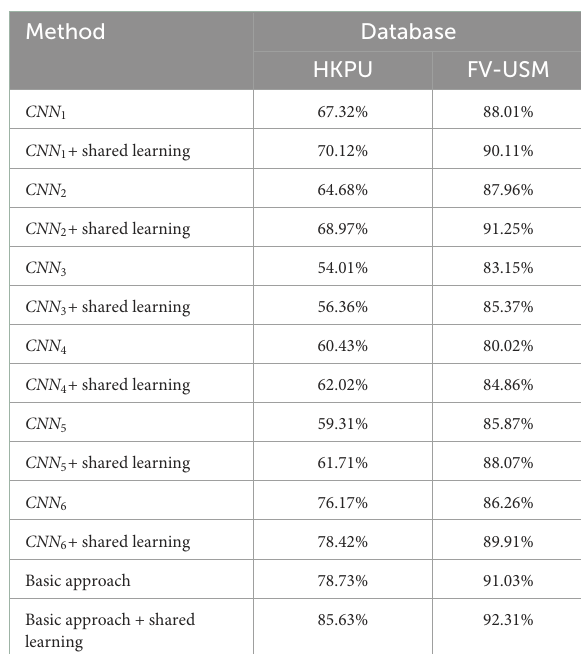
TABLE 6 Performance comparisons of shared learning in different